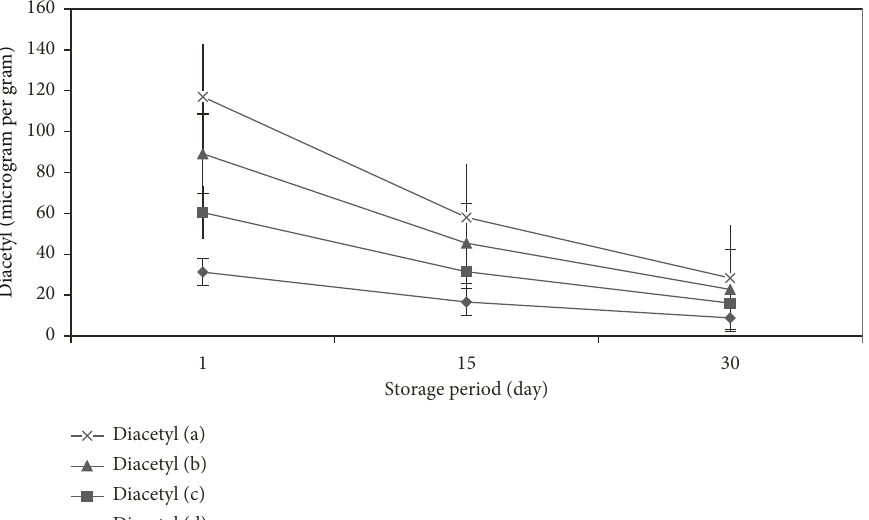
Figure 8: Changes in diacetyl ∗∗ ( µ g/g) during storage of Iranian UF cheese ∗ treated by KCl and NaCl during 30days of storage period. ∗ (a) 3% NaCl (control), (b) 1.50% NaCl+1.50% KCl, (c) 1.00% NaCl+2.00% KCl, and (d) 0.75% NaCl+2.25% KCl. ∗∗ means at the same age differed significantly ( P < 0 .